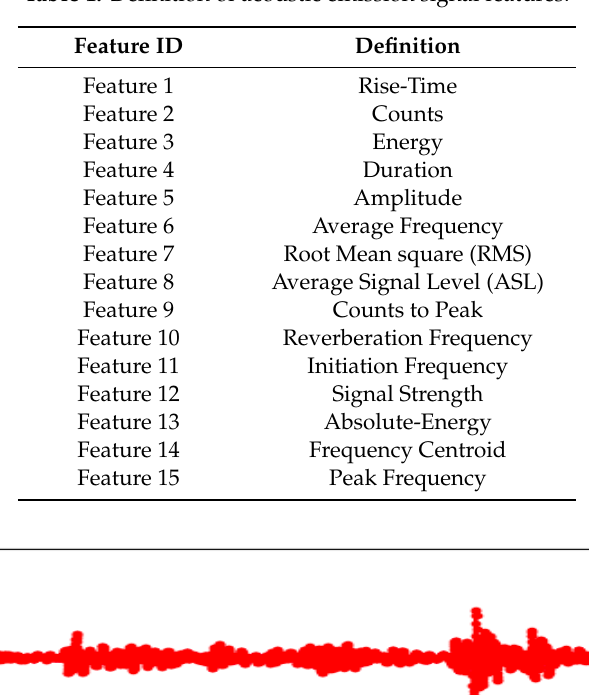
Table 1. Definition of acoustic emission signal features.